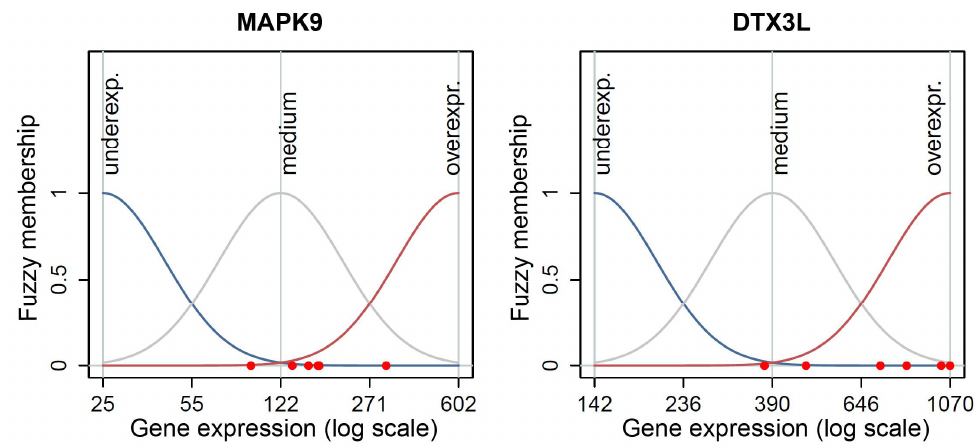
Figure 3. The fuzzy sets defined over the gene expression of MAPK9 and DTX3L for the KS samples. As can be seen, fuzzy rules are easily understood by users who are not